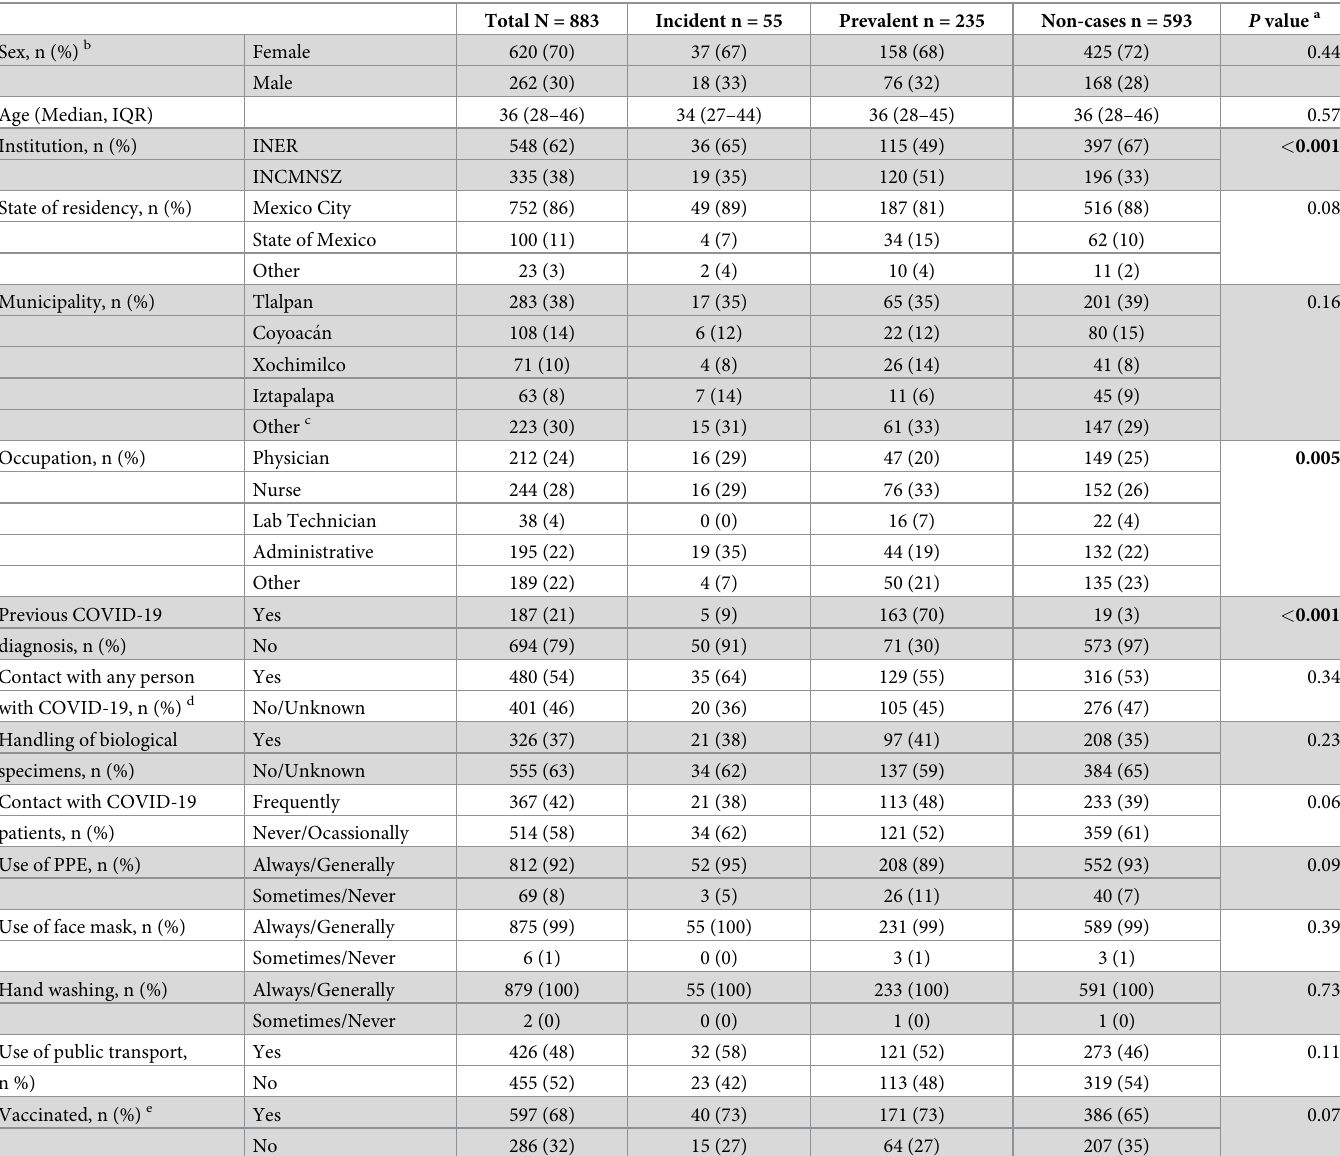
Table 1. Baseline characteristics of healthcare personal of two of the largest COVID-19 referral hospitals in Mexico City by study group, October 2020-June